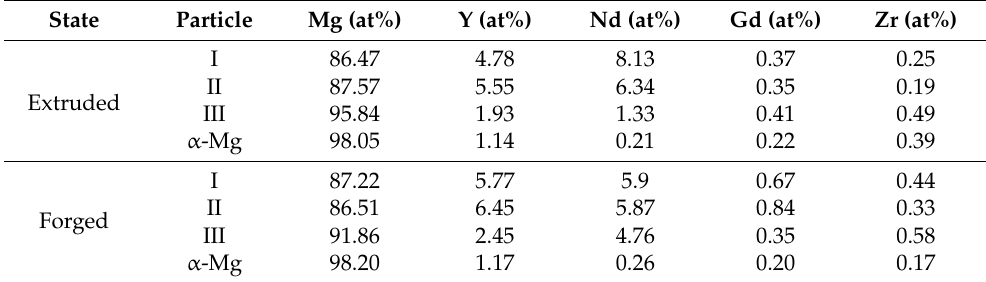
Table 1. The chemical composition of two deformed magnesium